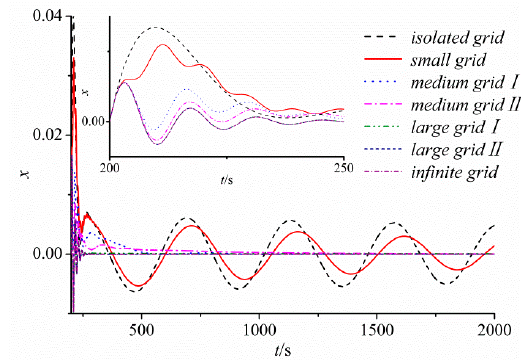
Figure 18. Transient process of the hydro-turbine governing system under the joint effect of the power grid and surge tank [75].